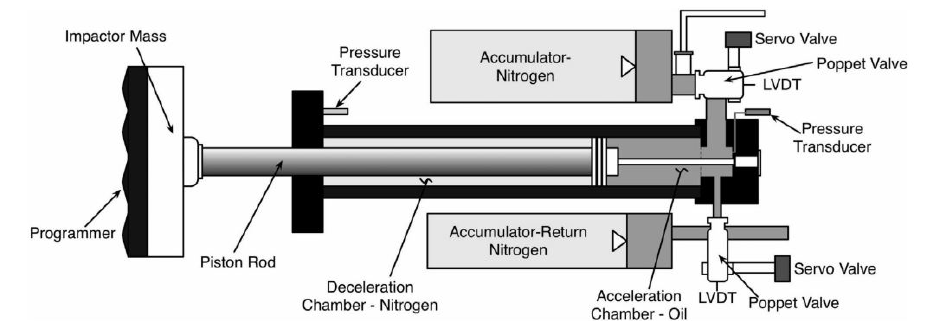
Figure 4. Schematic of the MTS blast generator.